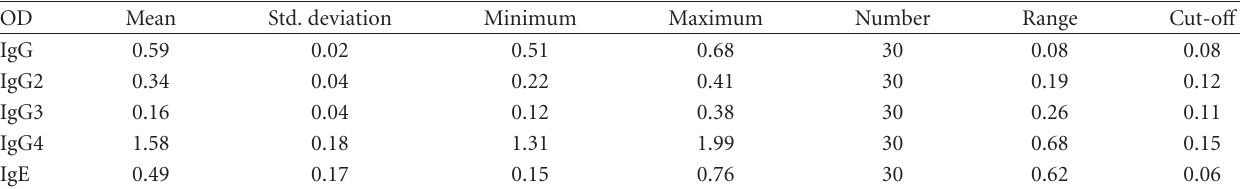
Figure 1: SDS PAGE showing di ff erent fractions of human and animal HCFs. MW: molecular weight; H: human; B: antigen B; AgK: antigen hydatid kit; SH: sheep; M: mice; C: cattle. Table 1: The mean OD values of IgG class and subclass responses of 30 naturally infected hyadid patients against human cystic crude fluid antigens.